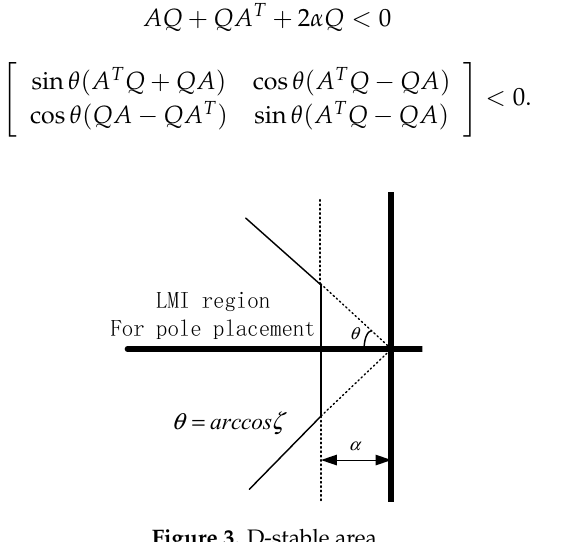
Figure 3. D-stable area. Figure 3. D-stable